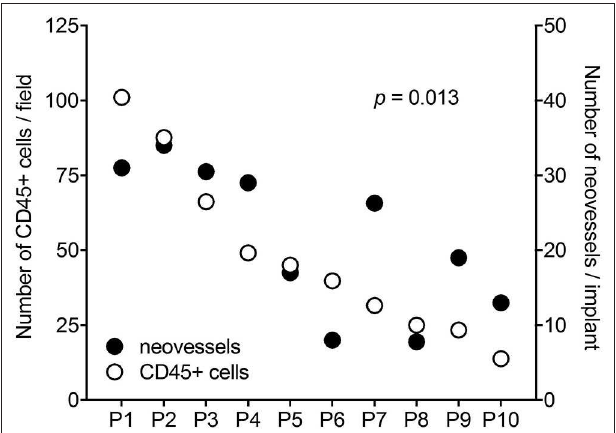
FIGURE 4 | Correlation between the angiogenic and inflammatory responses triggered by individual PDR vitreous samples in the chick embryo CAM. Vitreous samples from 10 PDR patients were individually tested in the CAM assay. A significant relationship was observed between the number of neovessels and of CD45 + infiltrating cells induced by each vitreous sample.